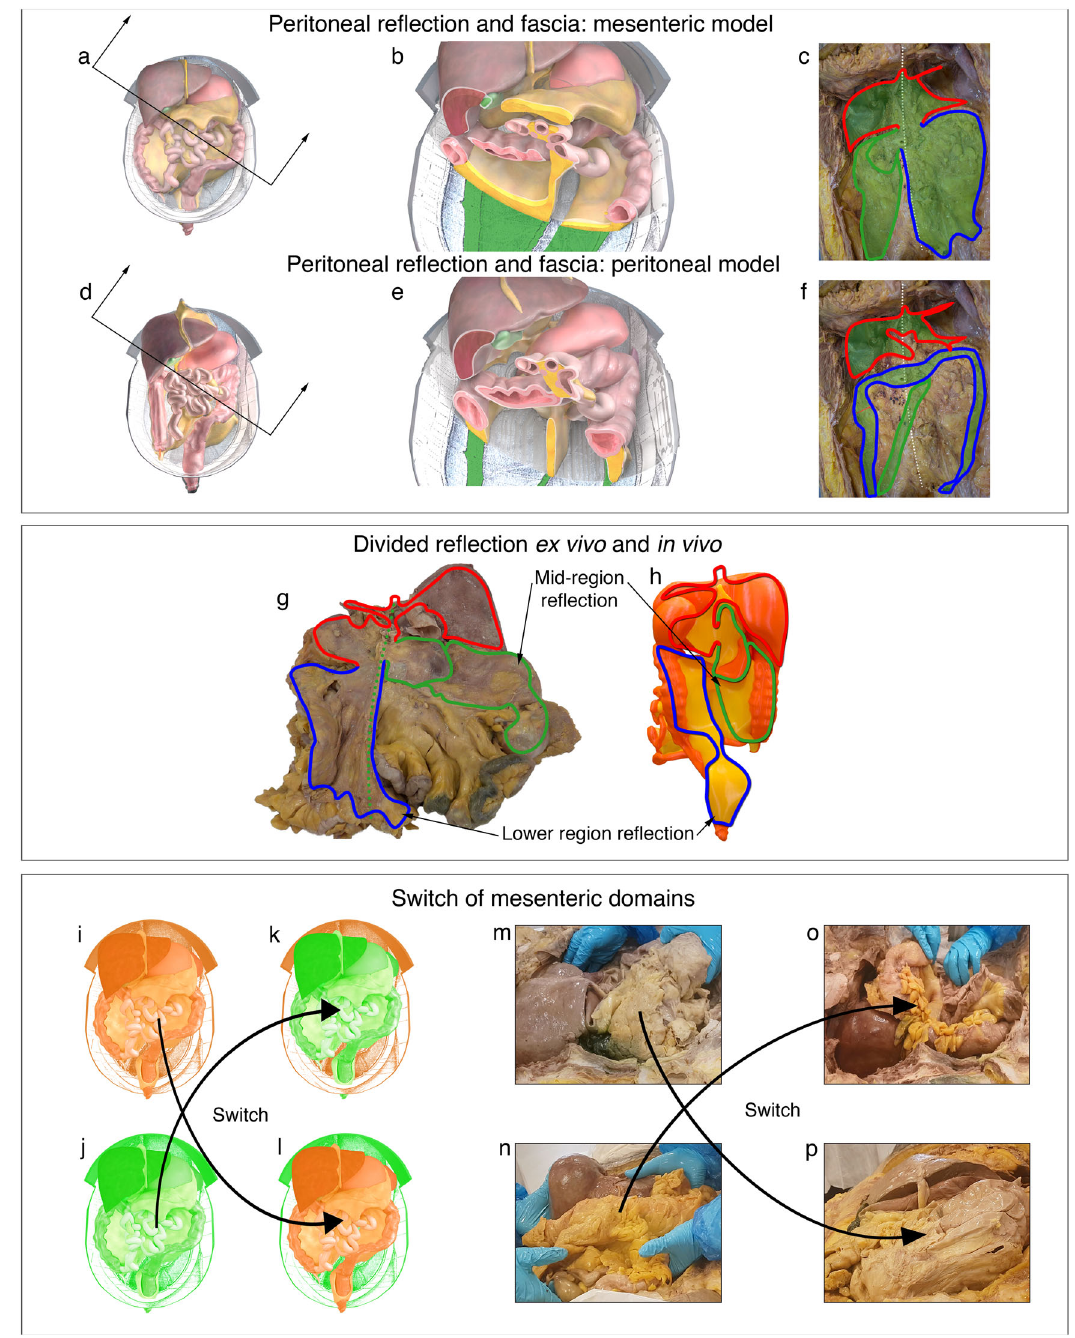
Fig. 5 Mesenteric based anatomy. Illustrations of the mesenteric model of the abdomen before ( a ), after ( b ) sectioning. c Photograph of the cadaveric non-mesenteric domain (schematic indicates the distribution of the re fl ection). Illustrations of the peritoneal model before ( d ), and after ( e ) sectioning. f Schematic indicating peritoneal based description of the mesentery/peritoneum. Photographs showing the posterior aspect of the ex vivo mesentery ( g ) and 3D printed mesentery ( h ) and re fl ection schematically superimposed. colour code: upper region (red), mid-region (green), lower region (blue). i – p Panel demonstrating switching of the mesenteric domain between cadavers in schematic ( i – l ) and cadaveric ( m – p )